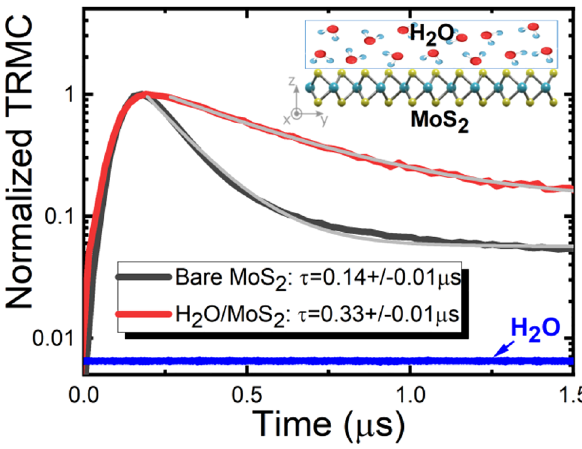
Figure 5: Normalized transient photoconductivity of bare MoS 2 (black line) and MoS 2 covered by water (red line). The gray lines represent the fi ts with exponential decay. No TRMC signal was observed from the water fi lm deposited on quartz. The water TRMC traceisplottedwithabluelinewithanoffsetaddedtovisualizeiton the adopted scale in the fi